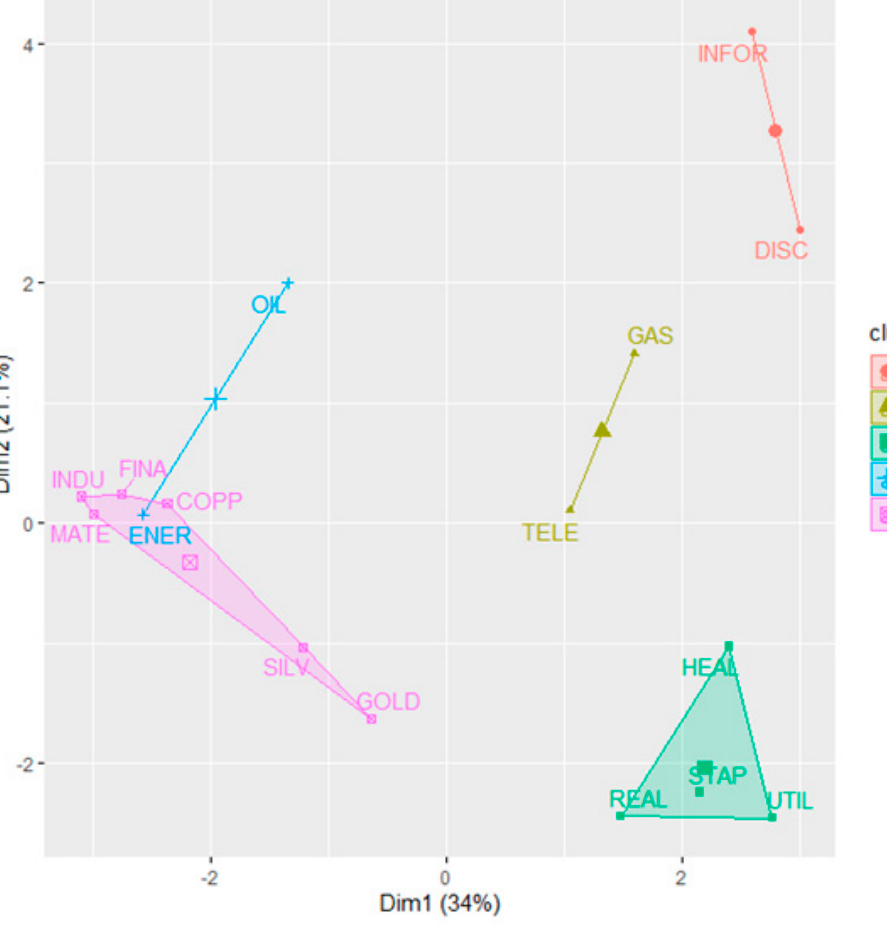
Figure 4. Cluster analysis results for time scale 3.